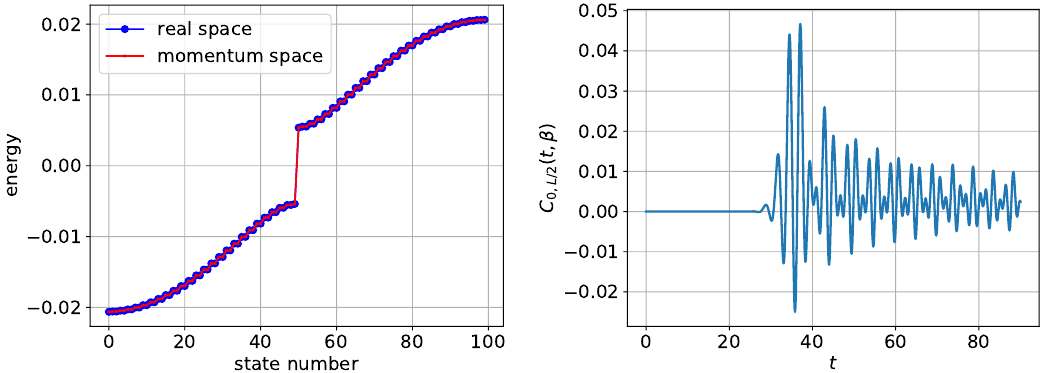
Figure 2: (a) the spectrum [ in units of J ] of the SSH Hamiltonian in real and momen- ( t ) , cf. Eq. (6) as a function tum space. (b) The non-equal time correlator C i = 0, j = L / 2 of time. The parameters are δ J / J = 0.1, ∆ / J = 0.5, J β = 100.0 and L =